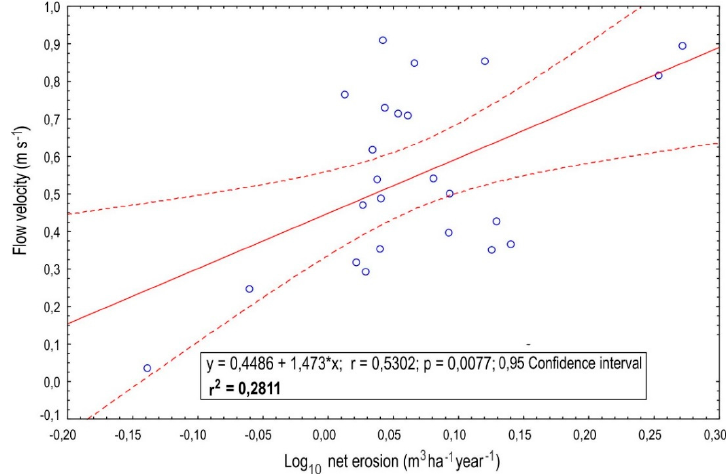
Figure 8. Relationship between the flow velocity and net erosion within the erosion gully formed within the investigated road.